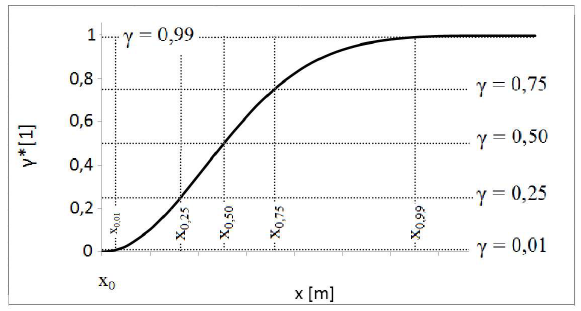
Fig. 4 . Boundary layer tranzition – process mdescription using intermittency coeffitient